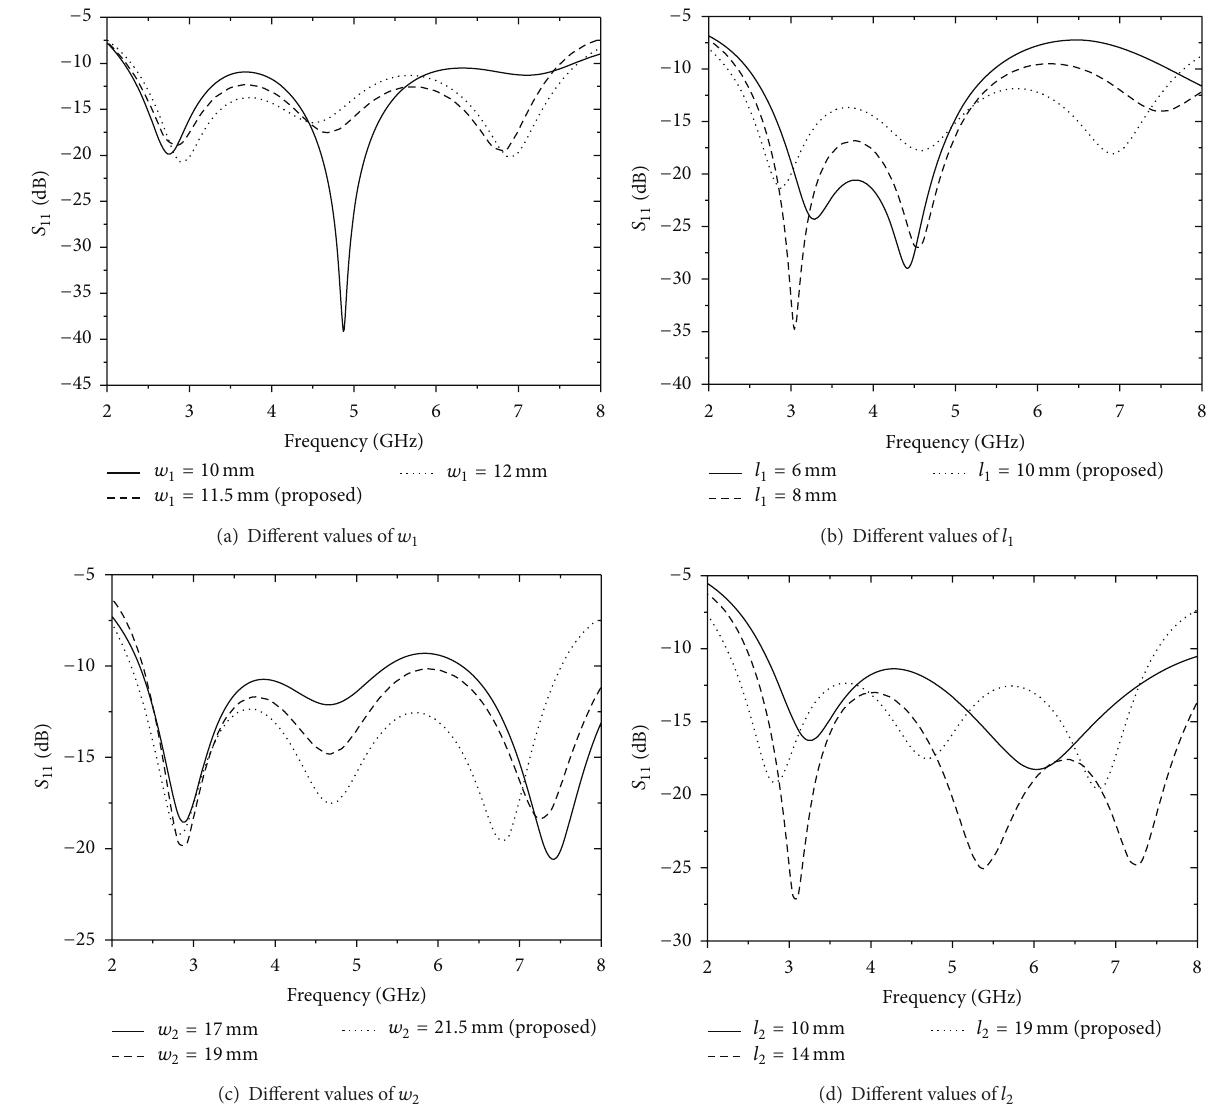
Figure 3: Frequency behavior of the scattering parameter 𝑆 11 of the T-shaped antenna for different values of the geometrical